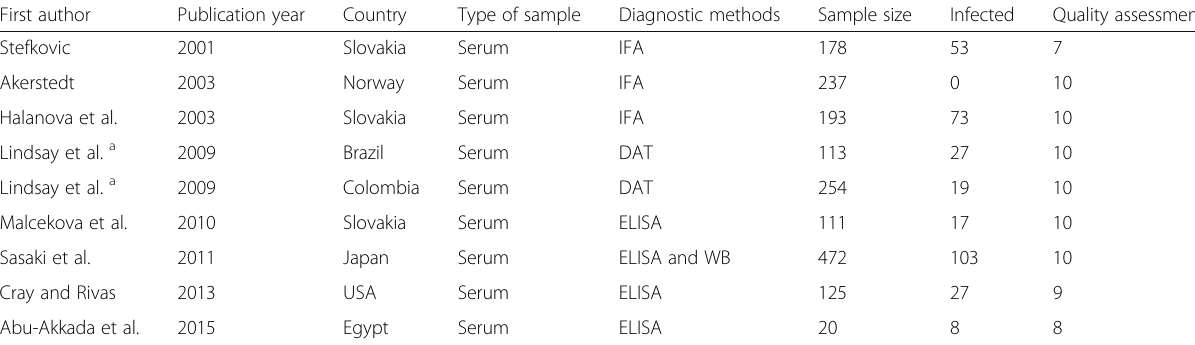
Table 3 All the studies investigating the global prevalence of microsporidia in dogs according to serological